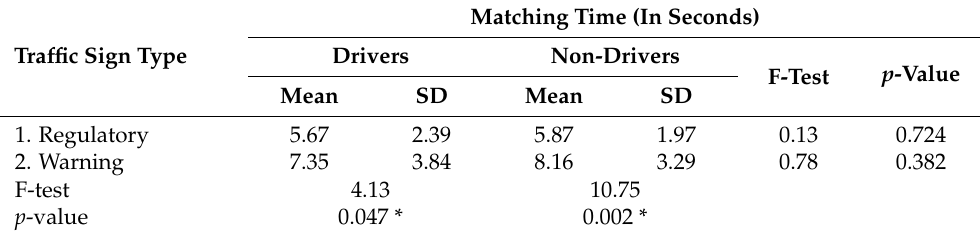
Table 7. Matching time of drivers and nondrivers vs. traffic sign types.